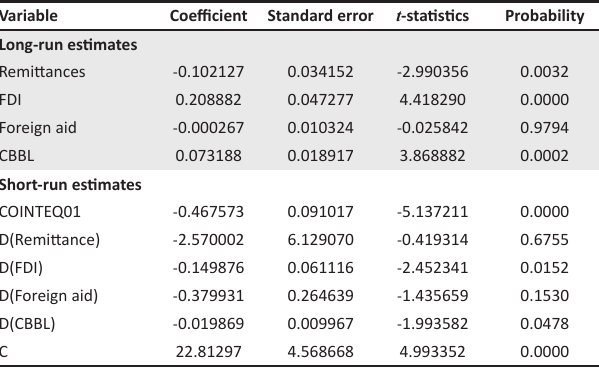
TABLE 2: Kao panel cointegration test results. TABLE 5: The panel autoregressive distributed lag estimation results.